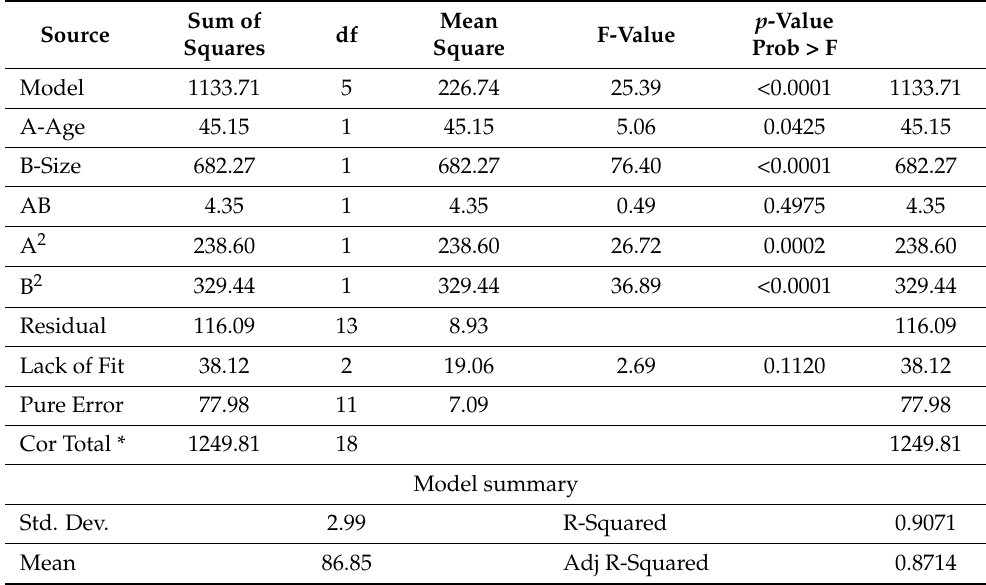
Table 3. Analysis of variance (ANOVA) and determination coefficients for the quadratic nonlinear model for viability [Partial sum of squares—Type